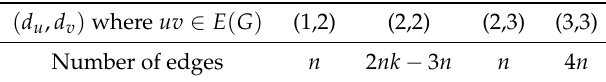
Table 2. The edge partition of the graph G for k > 1.